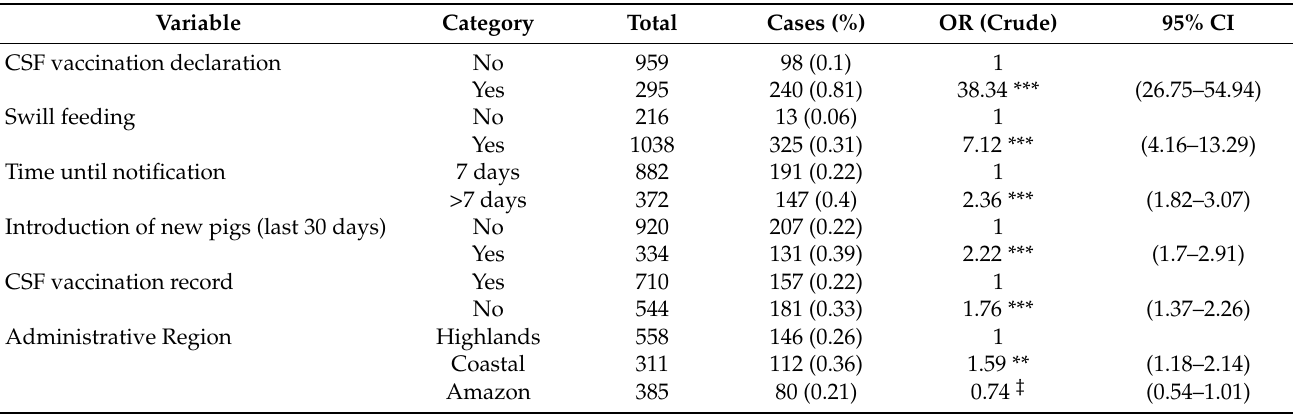
Table 3. Results of univariable logistic regression analyses, to assess associations of CSF